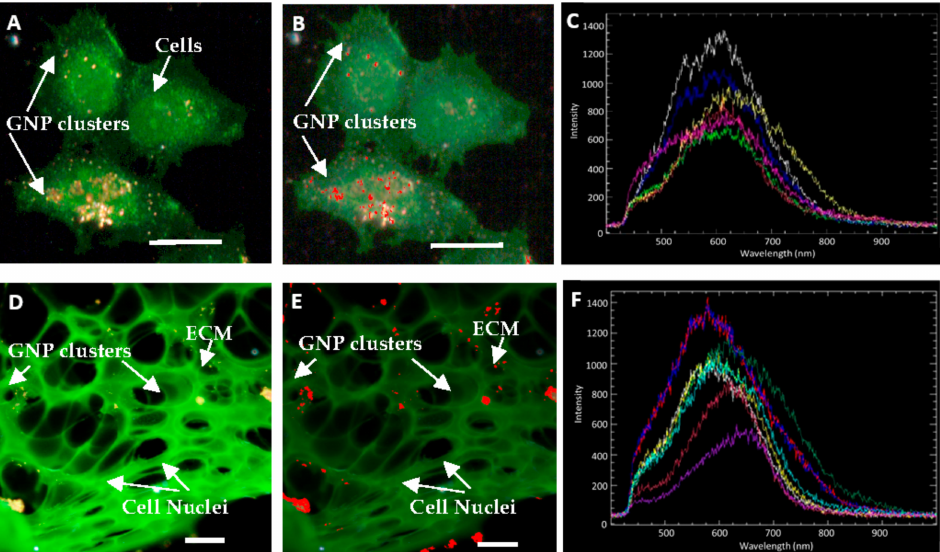
Figure 5. Comparison of monolayer and multilayer cell accumulation of GNPs ( A ) Dark field image of GNP accumulation in monolayer cells; ( B ) Hyperspectral image of GNP accumulation in monolayer cells. Pixels that are identified as GNPs are marked in red; ( C ) A few spectra collected from GNP clusters in Figure B ; ( D ) Dark field image of GNP accumulation in multilayer cell model.; ( E ) Hyperspectral image of GNP accumulation in a multilayer cell model. Pixels that are identified as GNPs are marked in red; ( F ) A few spectra of GNP clusters collected from Figure ( E ). Scale bars = 10 µ